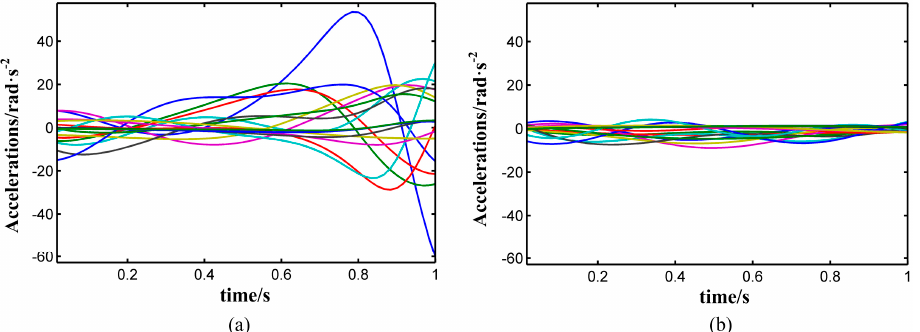
Figure 5. Generator rotor accelerations of 16 ‐ machine 68 ‐ bus system: ( a ) unstable case; and ( b ) stable case.